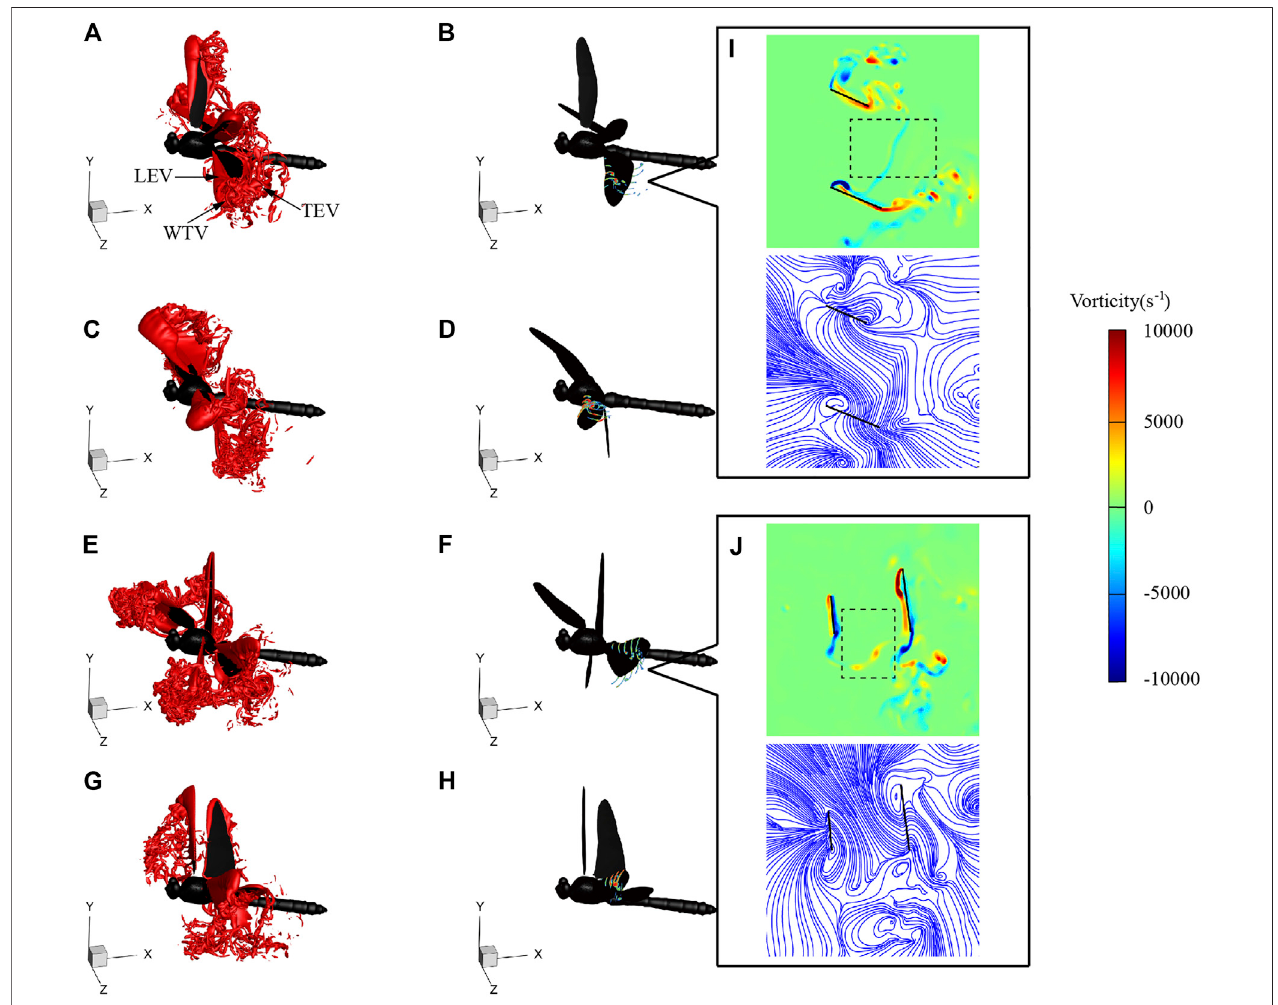
FIGURE10| VortexstructuresofSD1at74 ms[ (A) and (B) ],76.5 ms[ (C) and (D) ],80 ms[ (E) and (F) ],and82.5 ms[ (G) and (H) ].Vorticitycontourandstreamlines of the